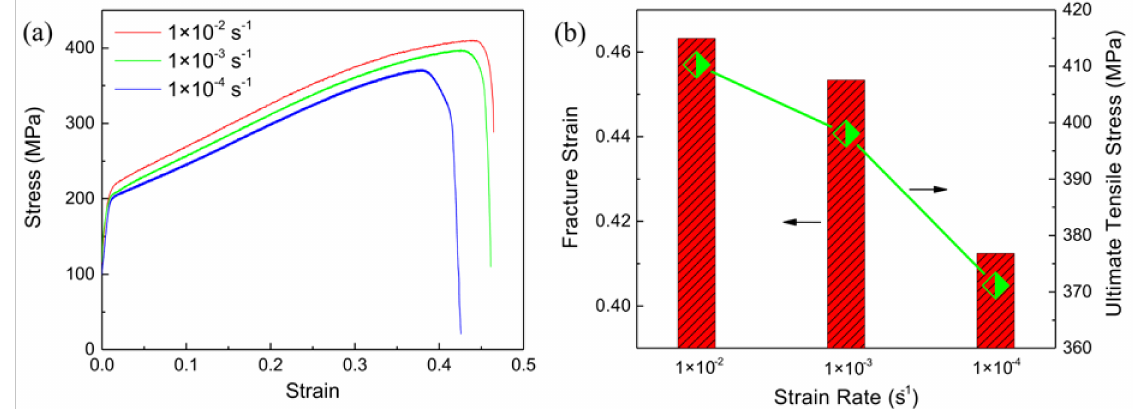
Figure 30. Stress–strain curves and data of a CoCrFeNi high entropy alloy under different strain rates: ( a ) stress-strain curves and ( b ) corresponding fracture strain and UTS. Reprinted with permission from ref. [53]. Copyright 2017 Elsevier.